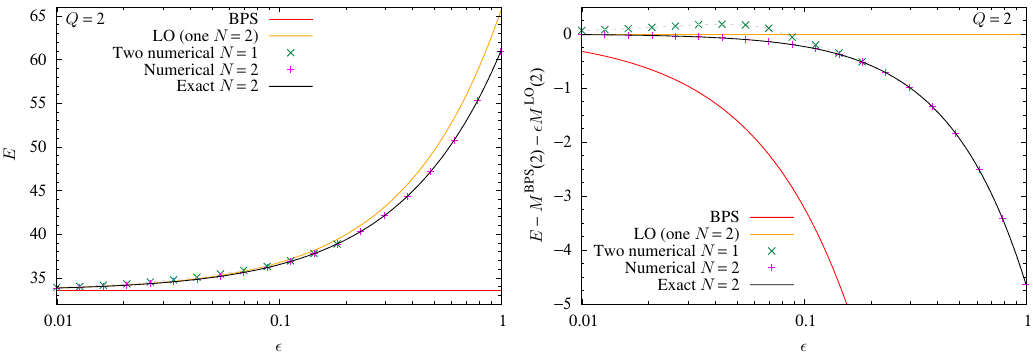
Figure 10 . The total energies of the baby-Skyrmion solutions in the Q = 2 sector. The red line is the BPS bound, the orange curve the LO correction (coming from the kinetic term) for a single N = 2 Skyrmion. The numerical solutions are: the two N = 1 Skyrmions side-by-side (green xs), and the axially symmetric N = 2 Skyrmion (magenta pluses). Finally, the latter numerical N = 2 solution is compared to the exact solution (using the 1-dimensional ODE). For clarity, the right-hand side panel shows the same data relative to the orange line, being the LO correction. At (cid:15) & 0 . 15 the two N = 1 ’s side-by-side become unstable and decay to the axially symmetric N = 2 .